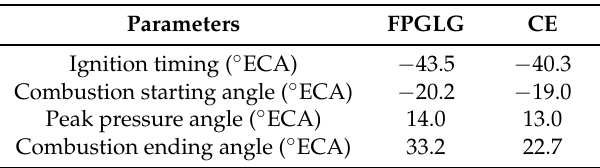
Table 6. Combustion duration comparison of the FPGLG and CE.